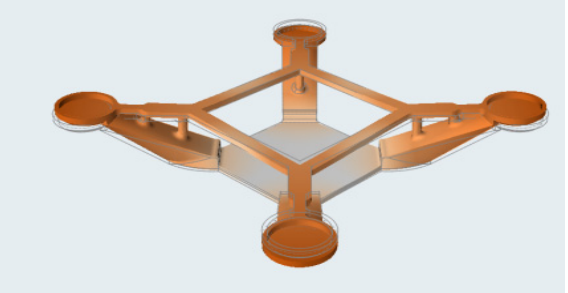
Figure 14. First mode shape and its corresponding frequency at 98.1 Hz.